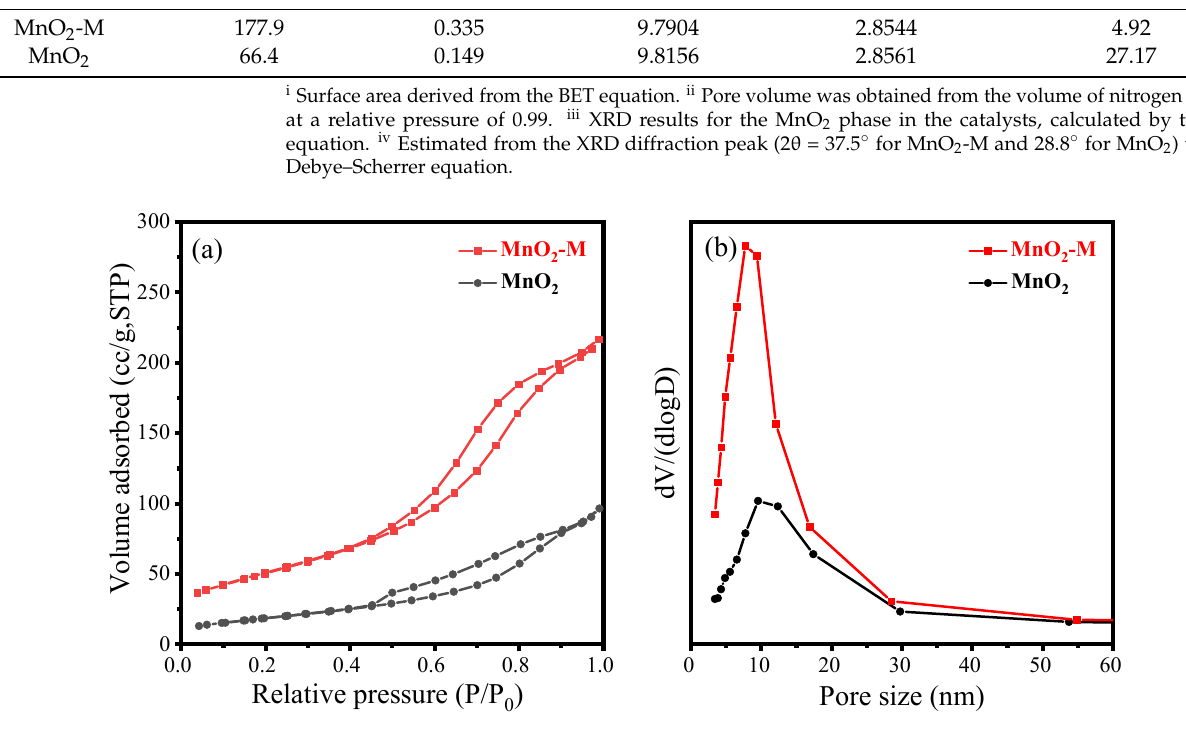
Figure 2. N 2 adsorption-desorption isotherms ( a ) and pore size distribution curves ( b ) of the cata-